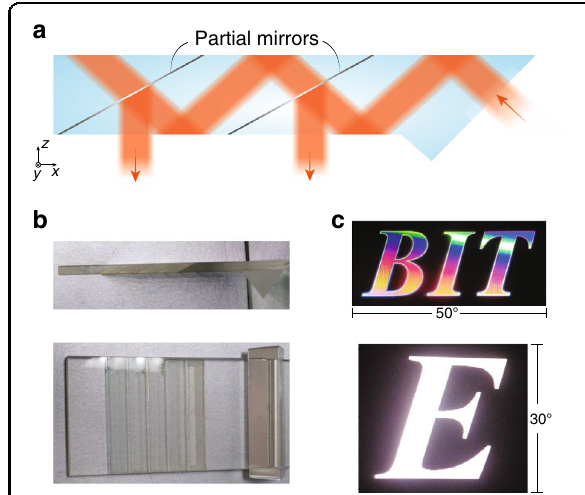
Fig. 15 Geometric waveguide combiner. a Schematic of the system con fi guration. b Geometric waveguide with fi ve partial mirrors. c Image photos demonstrating system FoV. Adapted from b , c ref.